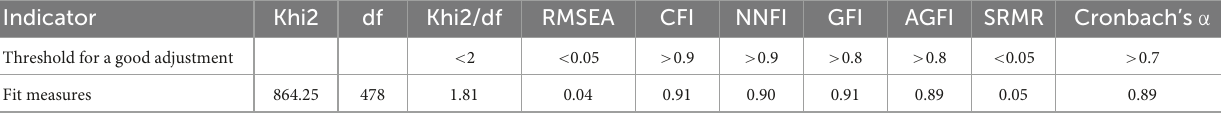
TABLE 4 Results of the confirmatory factorial analysis for the assessment of internal consistency reliability of Amylo-AFFECT questionnaire. Indicator Threshold for a good